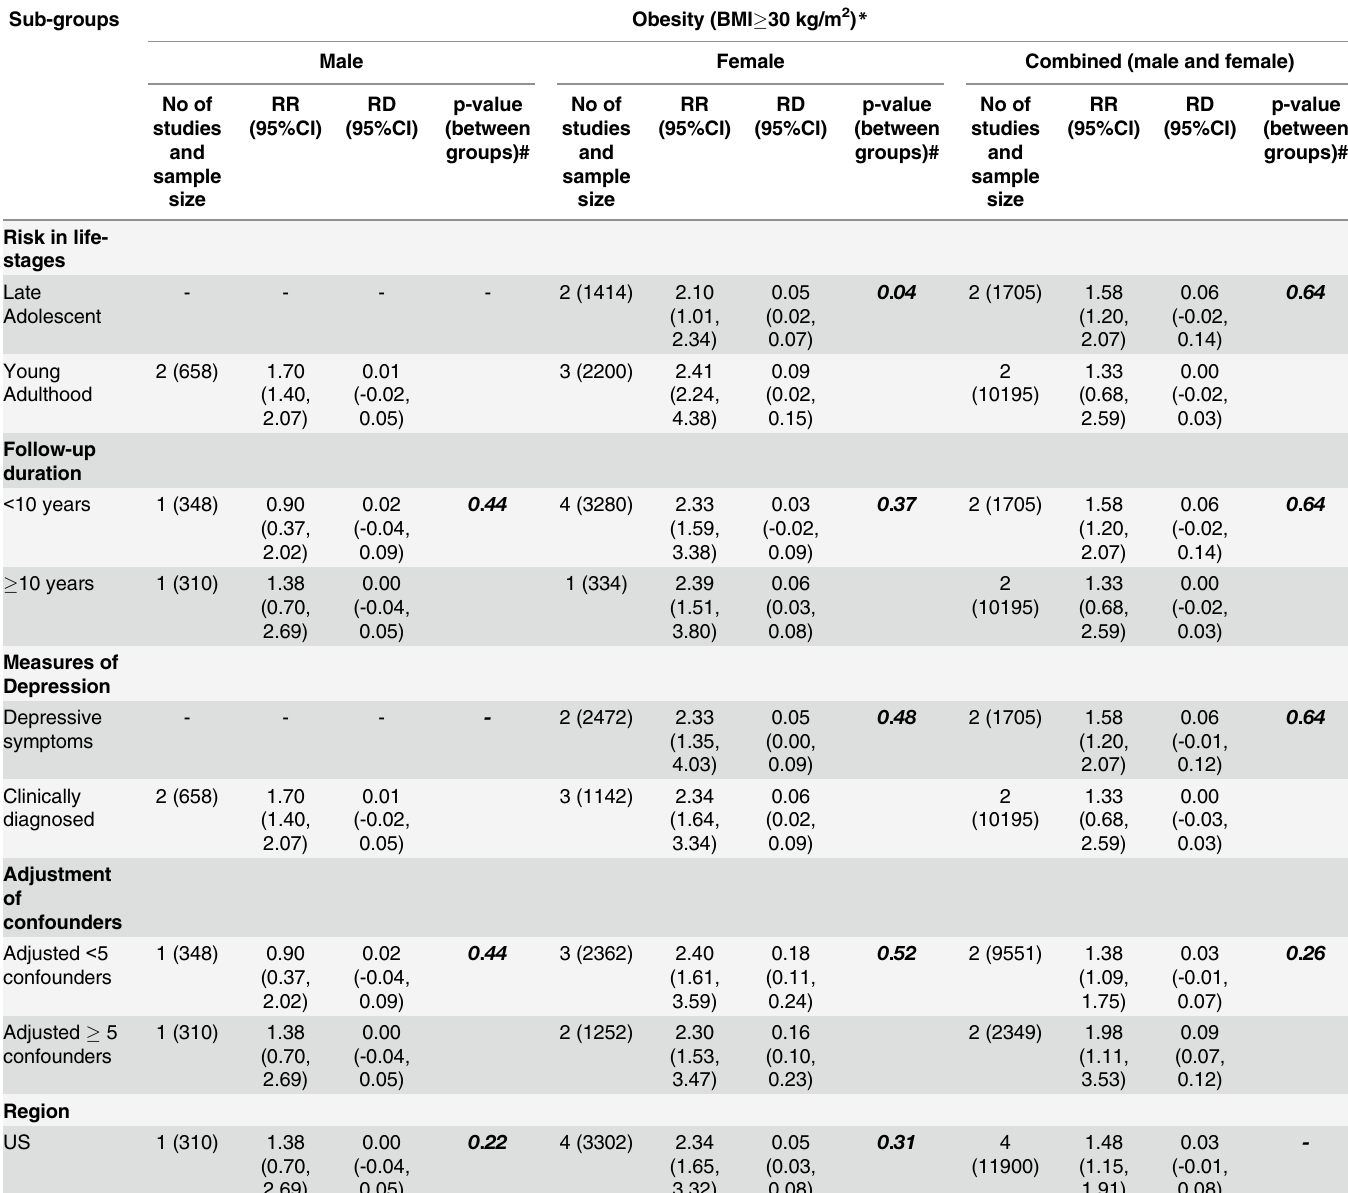
Table 3. Sensitivity analyses of depression leading to